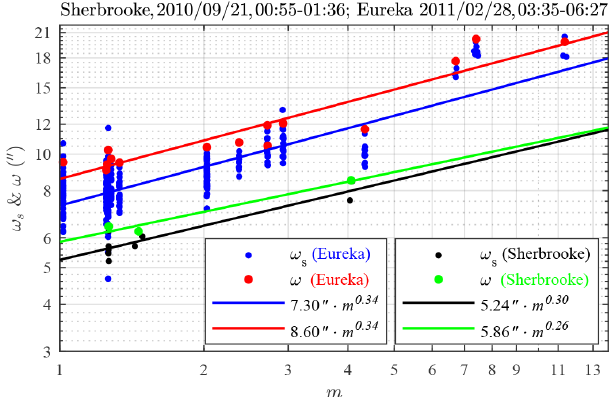
Figure 2. Very large starspots measured at the mid-latitude site of Sherbrooke, Québec, Canada (M703 telescope), and the High Arctic site of Eureka, Nunavut, Canada (C11 telescope), show a weaker air mass dependence than expected. The symbol ω s is associated with short time exposures, whereas ω represents long time